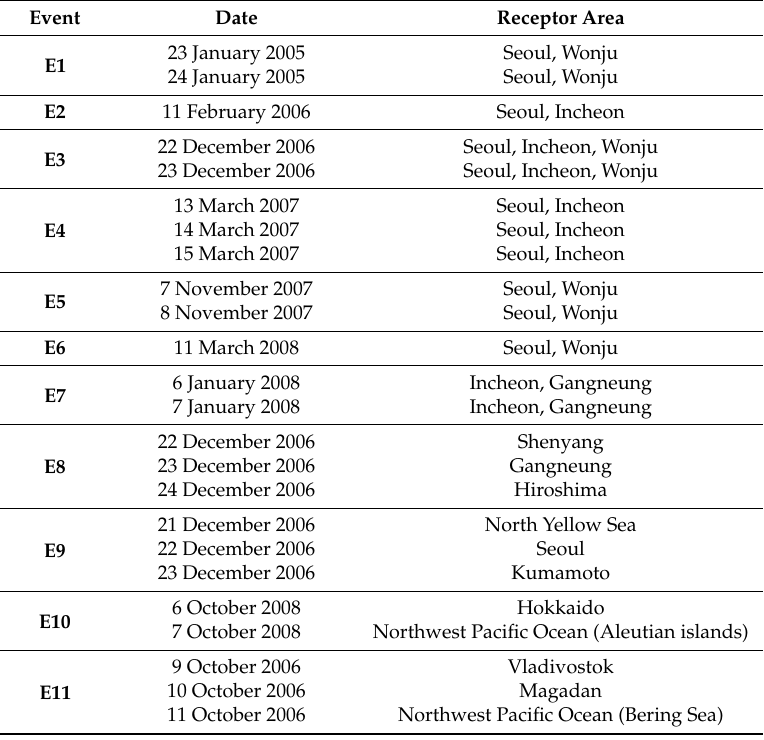
Table 1. LRT-SO 2 events determined for each receptor